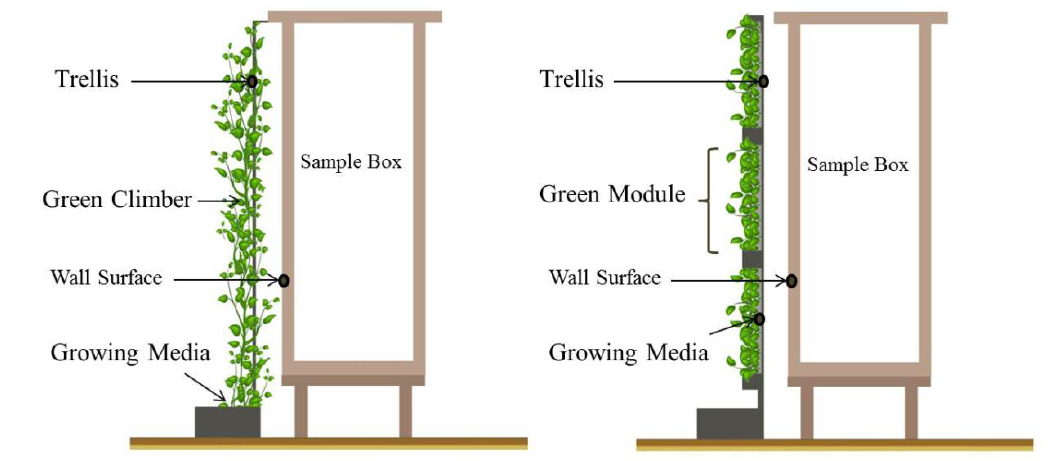
Fig. 1. Green facade (left) and living wall